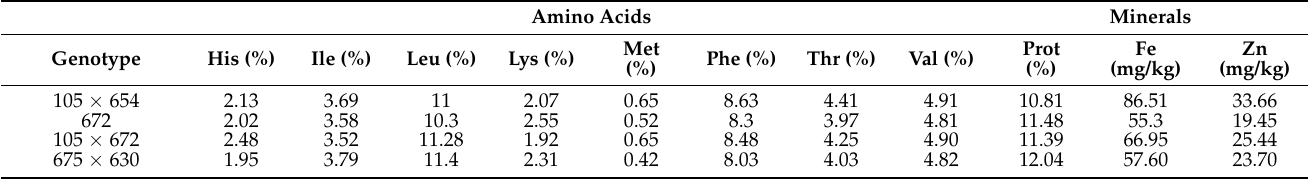
Table 3. Mean compositions for amino acids, protein, iron, and zinc among 12 elite